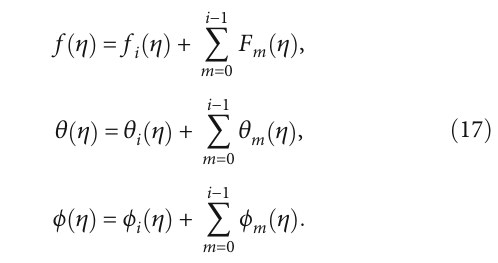
on the concentration pro fi c